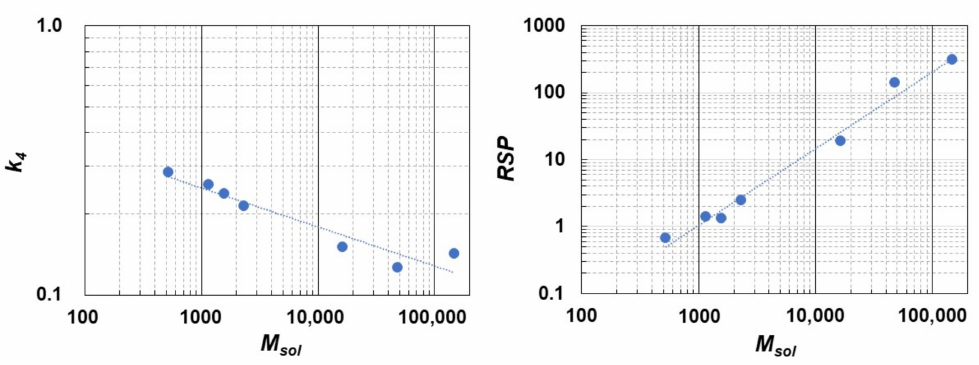
Figure 5. k 4 and RSP values plotted against M sol . Both parameters can be approximated by exponentiation with M sol